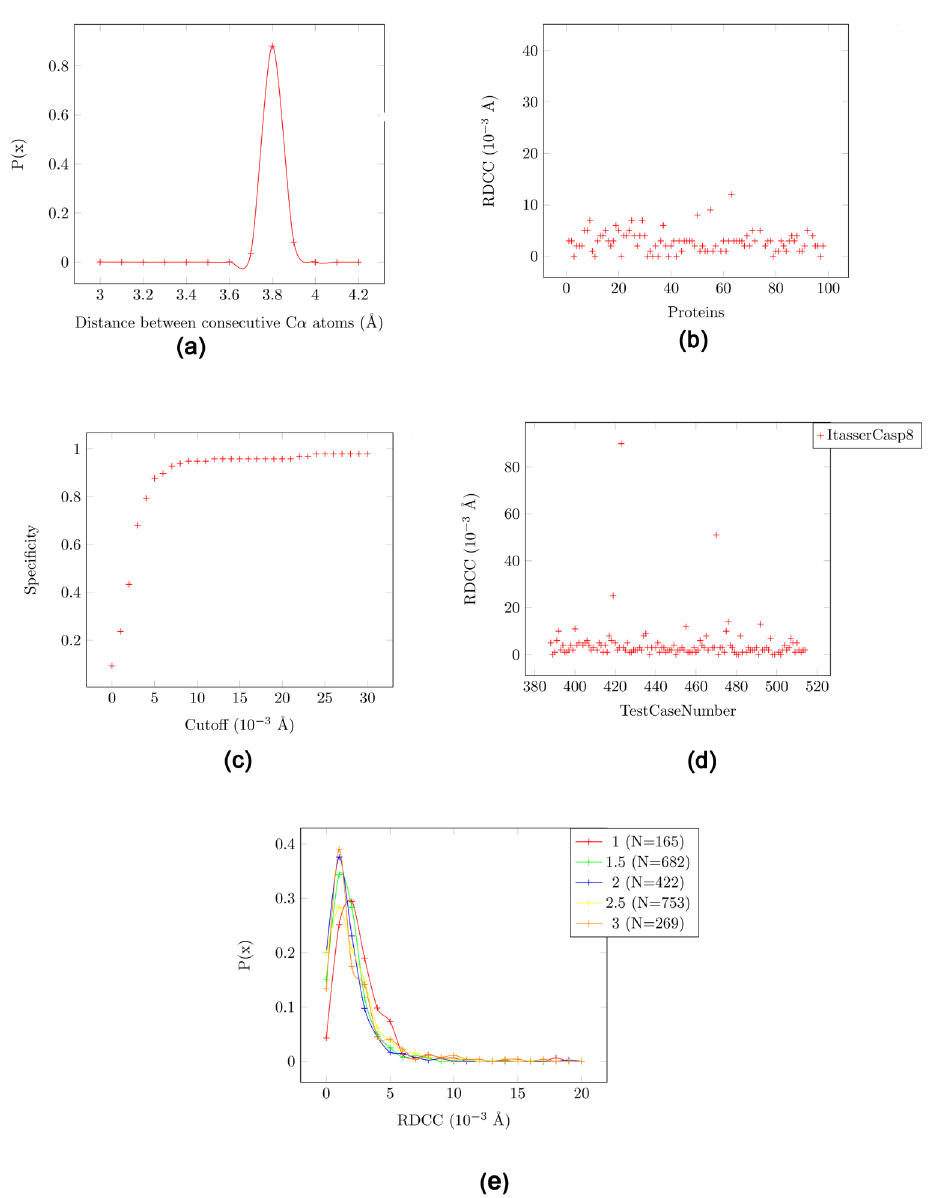
Figure 1. Root-mean-square deviation of the distance of consecutive C a (RDCC) atoms from the ideal value of 3.8 Å. ( a ) Probability distribution (P(x)) for the distance of consecutive C a in ~100 proteins in the top100H database. ( b ) RDCC in ~100 high quality structures from the top100H database. ( c ) Variation in specificity based on the cutoff value. We choose 0.012 Å as the cutoff for filtering out non-native structures. ( d ) RDCC in I-TASSER CASP8 decoy suite. ( e ) RDCC for protein structures based on the